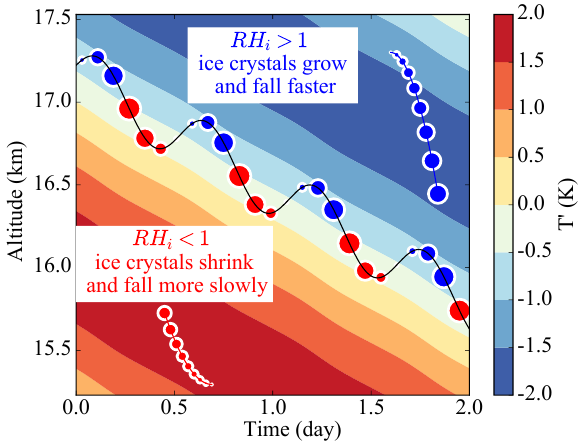
Figure 3. Representation in altitude–time space of an ice crystal = 0.85) simulations. The colors cor- trajectory in the moist (RH i c respond to the temperature anomaly profiles induced by the wave at the X position of the crystal, which also correspond to relative humidity anomalies. It is important to note that as a consequence Figure 4. Fraction F p of the wave phase space affected by the wave- of the crystal horizontal motion the X position at which the profiles driven localization, as a function of the period T = 2 π/ω and ver- = 0.85 and the pa- are taken changes with time. The black line corresponds to the ice tical wavelength λ z = 2 π/m of the wave. RH i c crystal trajectory and the circular markers represent the ice crystal rameters other than m and ω are given in Table 1. The regions of size. Blue circles indicate growing ice crystals (RH i > 1), whereas wave instability are not shown red circles indicate sublimating ice crystals. Idealized trajectories of growing (blue) and sublimating (red) crystals in constant RH i back- grounds are also shown for a pedagogic purpose in the lower left and upper right corners.